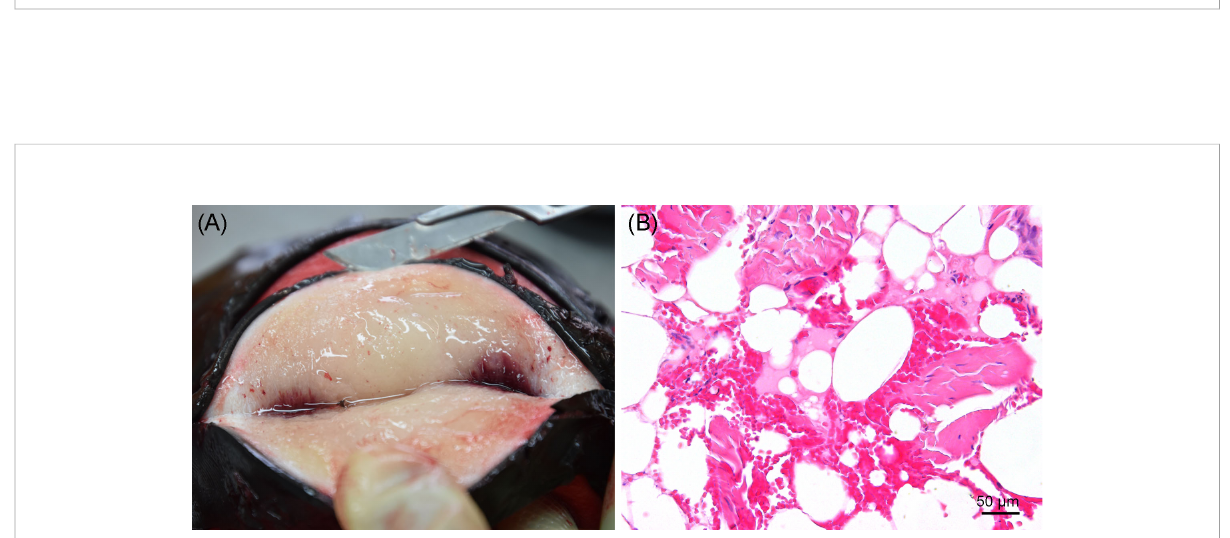
FIGURE 6 (A) Gross image of the melon at necropsy. (B) Focal acute hemorrhage in the fatty tissue of the melon; hematoxylin and eosin